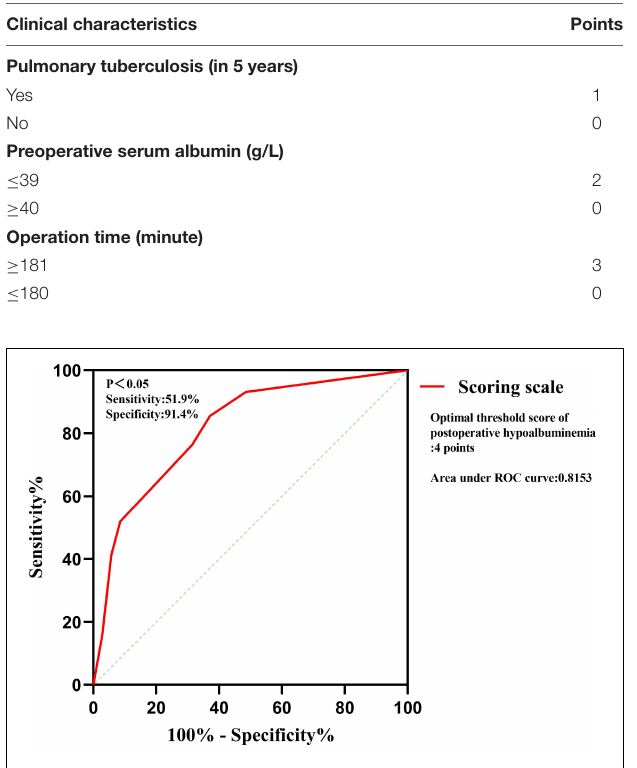
FIGURE 3 | ROC curve of the scoring scale.